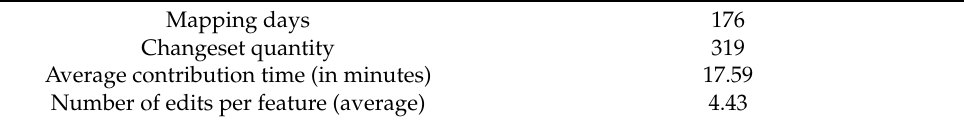
Table 3. Contribution intensity attributes prepared from the Mozambique history data for user 32744.